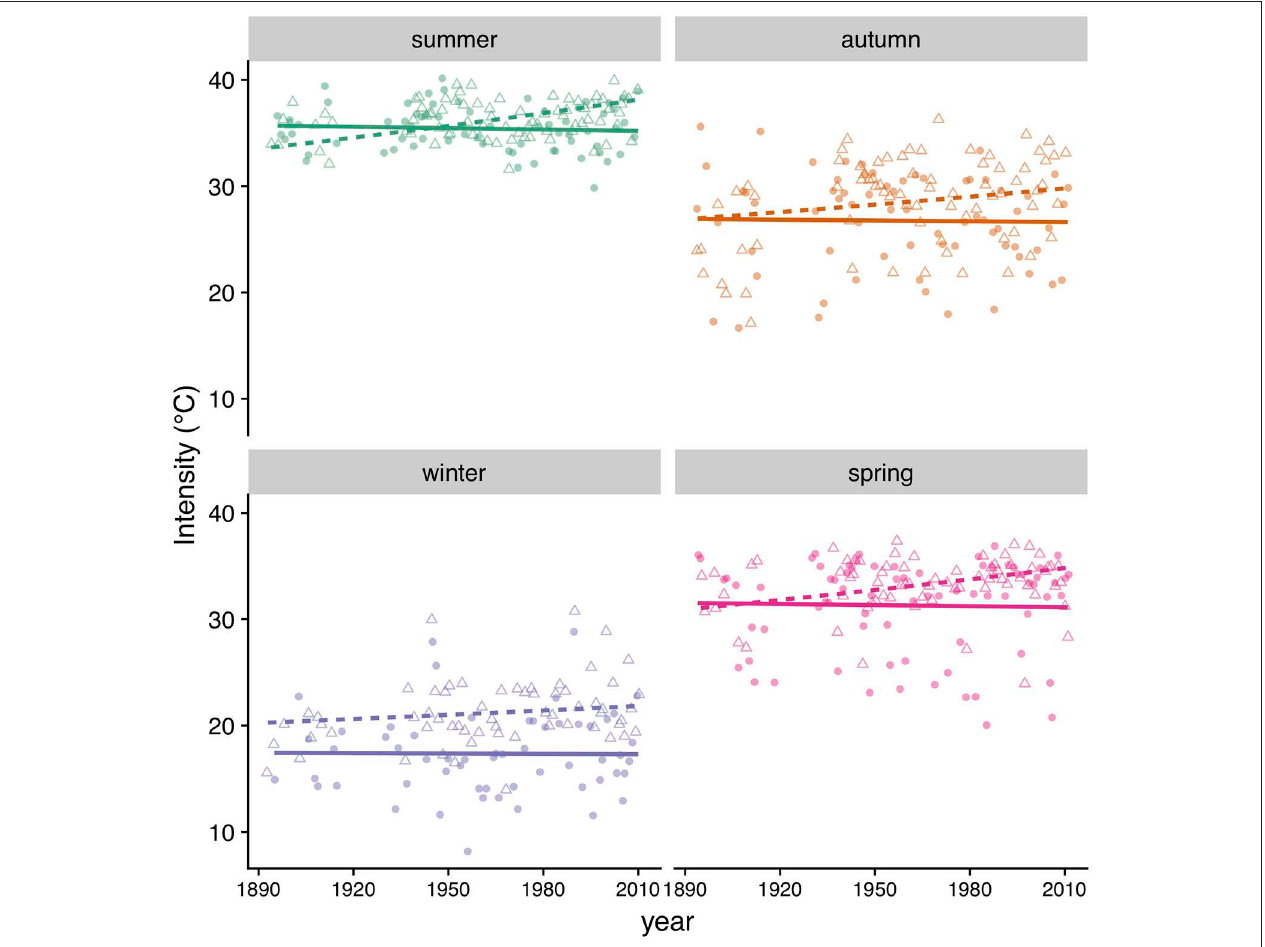
FIGURE 10 | Heatwave intensity (maximum temperature) by season in MD (triangles, dashed line) and MA (circles, solid line). Symbols correspond to data points and lines to model predictions ( Table 4 ).